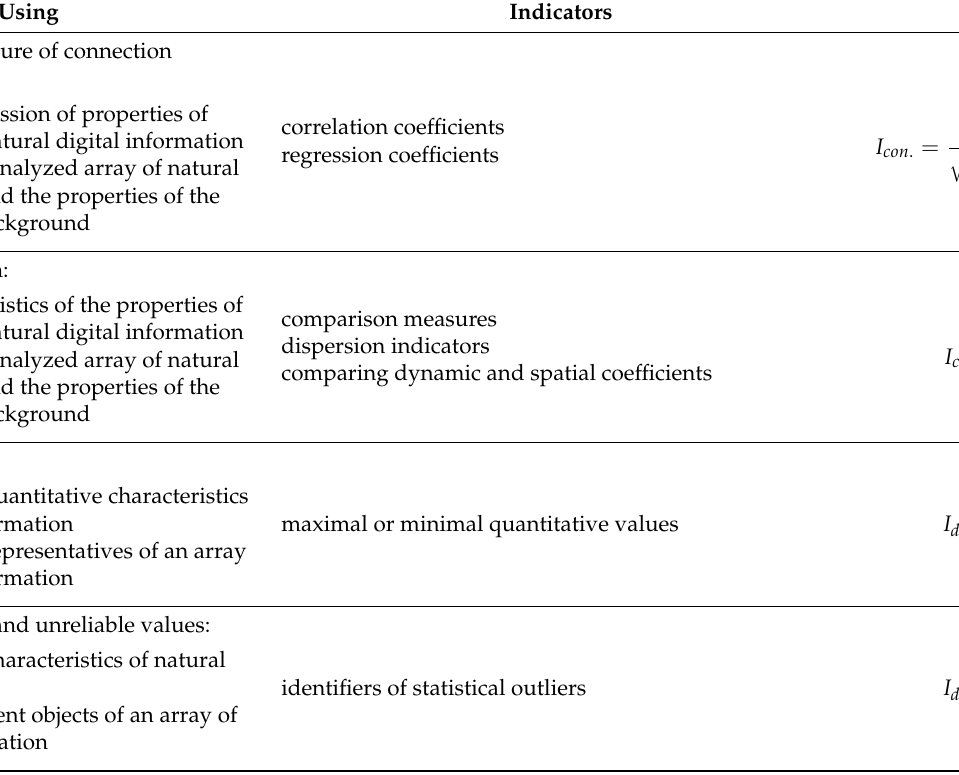
Table 2. Examples of metrics to quantify and analyze the properties of